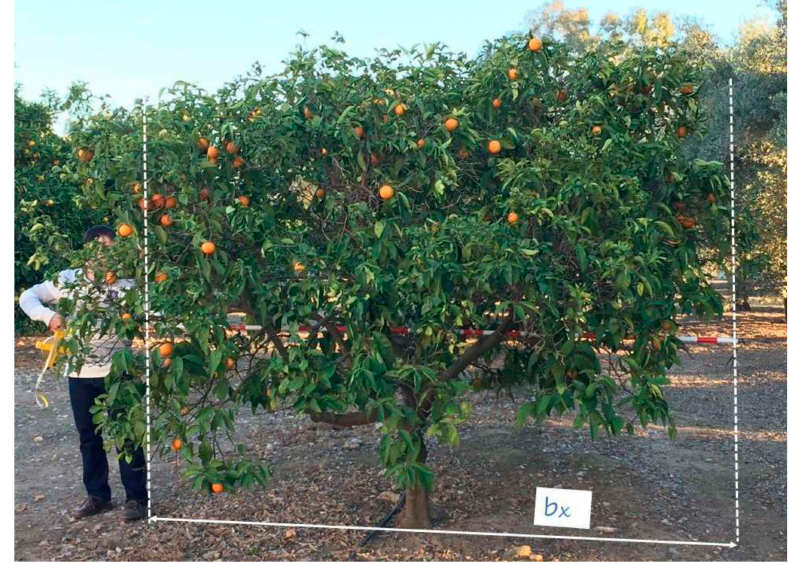
Figure 5. Tree crown size measurement by traditional method. b x is the semi-axe of the ellipsoid, Equation